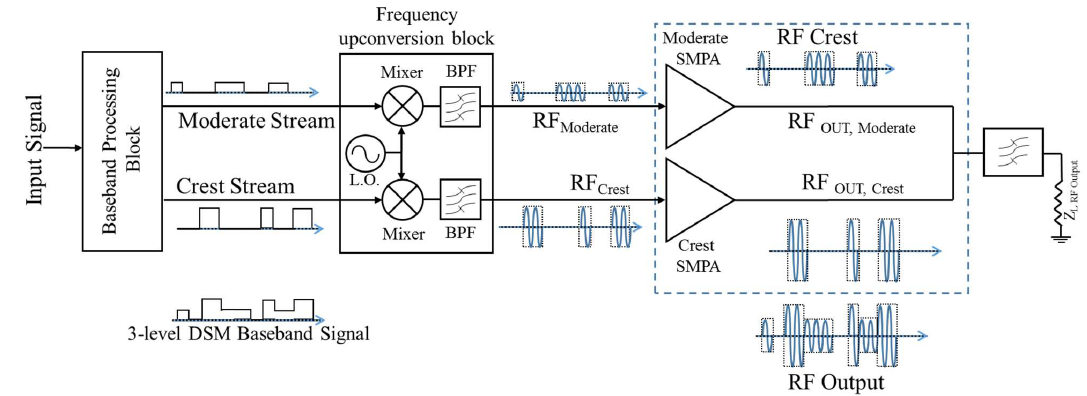
Figure 2. The three-level de-multiplexing quantization process.